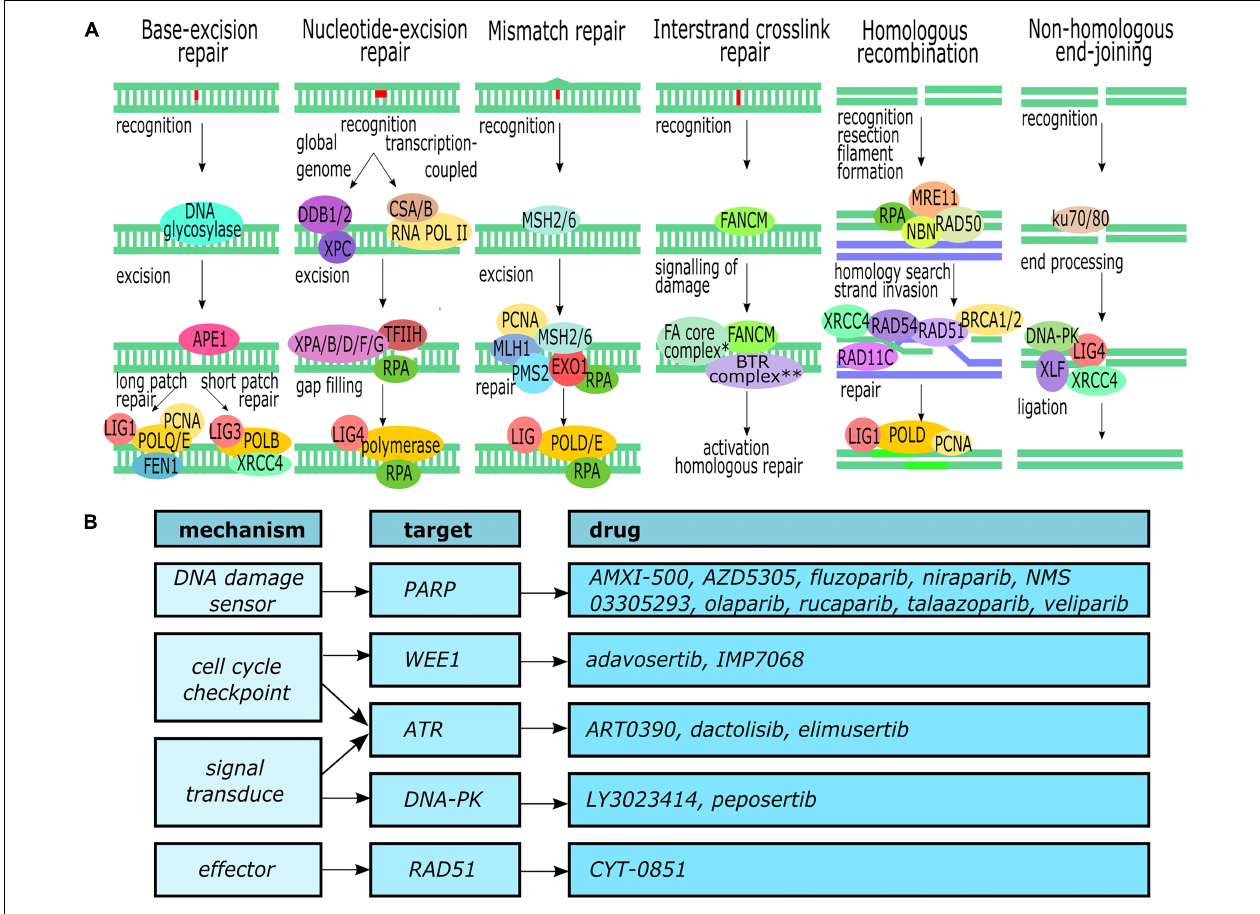
FIGURE 1 | DNA damage repair. (A) Overview of the major DNA repair pathways (Deans and West, 2011; Yang et al., 2016; Ranjha et al., 2018; Gupta and Heinen, 2019; Lee and Kang, 2019). ∗ The Fanconi anemia core complex consists of FANCA , FANCB , FANCC , FANCD , FANCE , FANCF , FANCG , and FAAP100 . ∗∗ The BTR complex consists of BLM , TOPOIII , RMI1 , and RMI2 . (B) Molecular targets within the DDR pathways and available inhibitors. This figure was created in